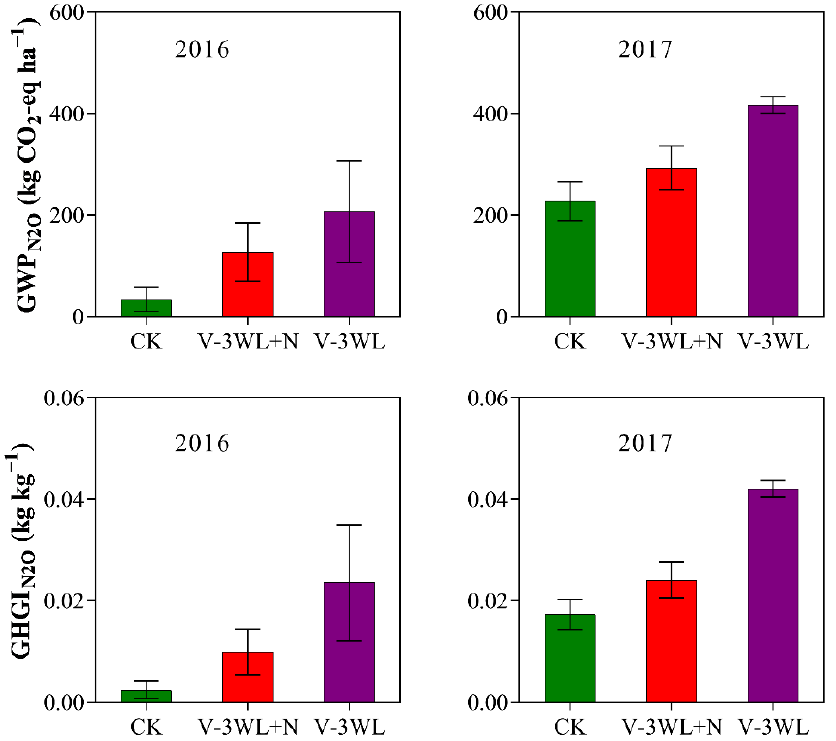
Figure 2. Effects of applying nitrapyrin on the warming potential under a waterlogged field. V-3WL, waterlogging treatment with urea application only; V-3WL+N, waterlogging treatment with urea and nitrapyrin application; CK, not waterlogged, but applied only urea. The error bars represent 95% confidence intervals.